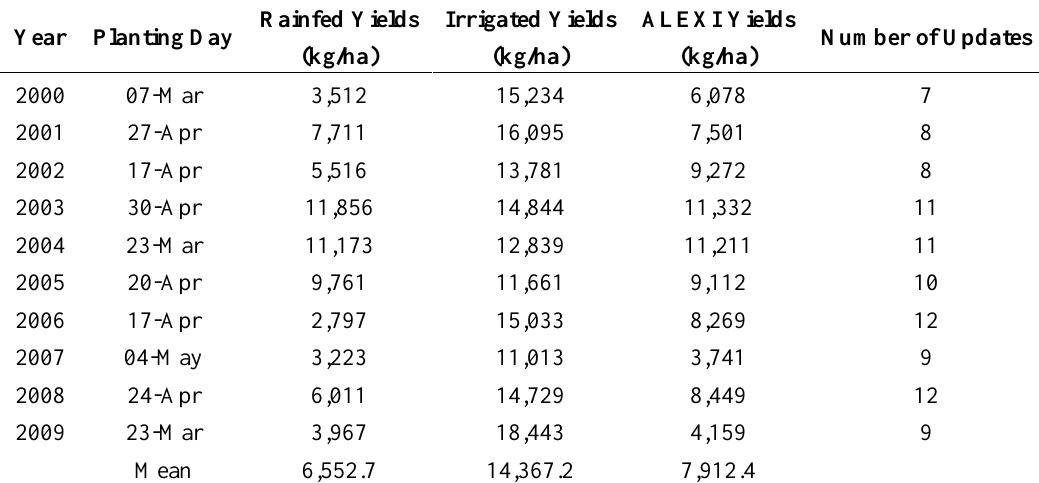
Table 2. DSSAT yield comparisons with pertinent